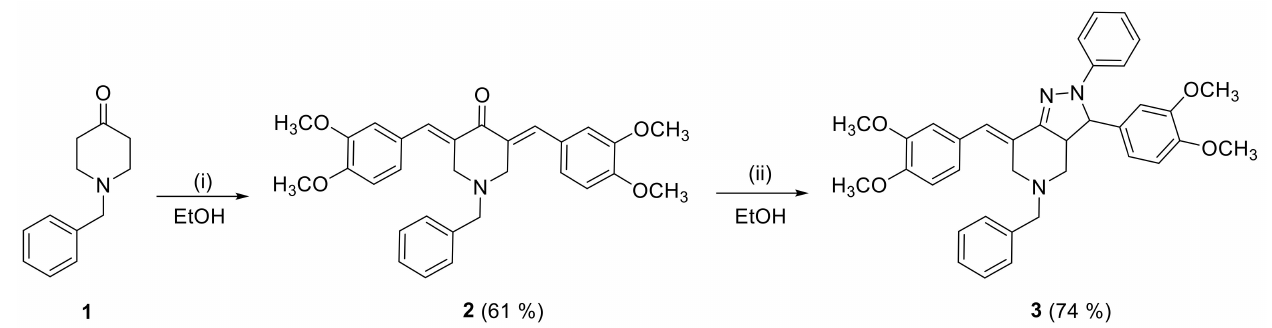
Figure 1. The synthesis route of the title compound; (i) 2 eq. of 3,4-dimethoxybenzaldehyde, 10% KOH, 180 W, 135 ◦ C, 1 h, (ii) 6 eq. of phenyl hydrazine, 10% KOH, refluxed at 80 ◦ C for 3